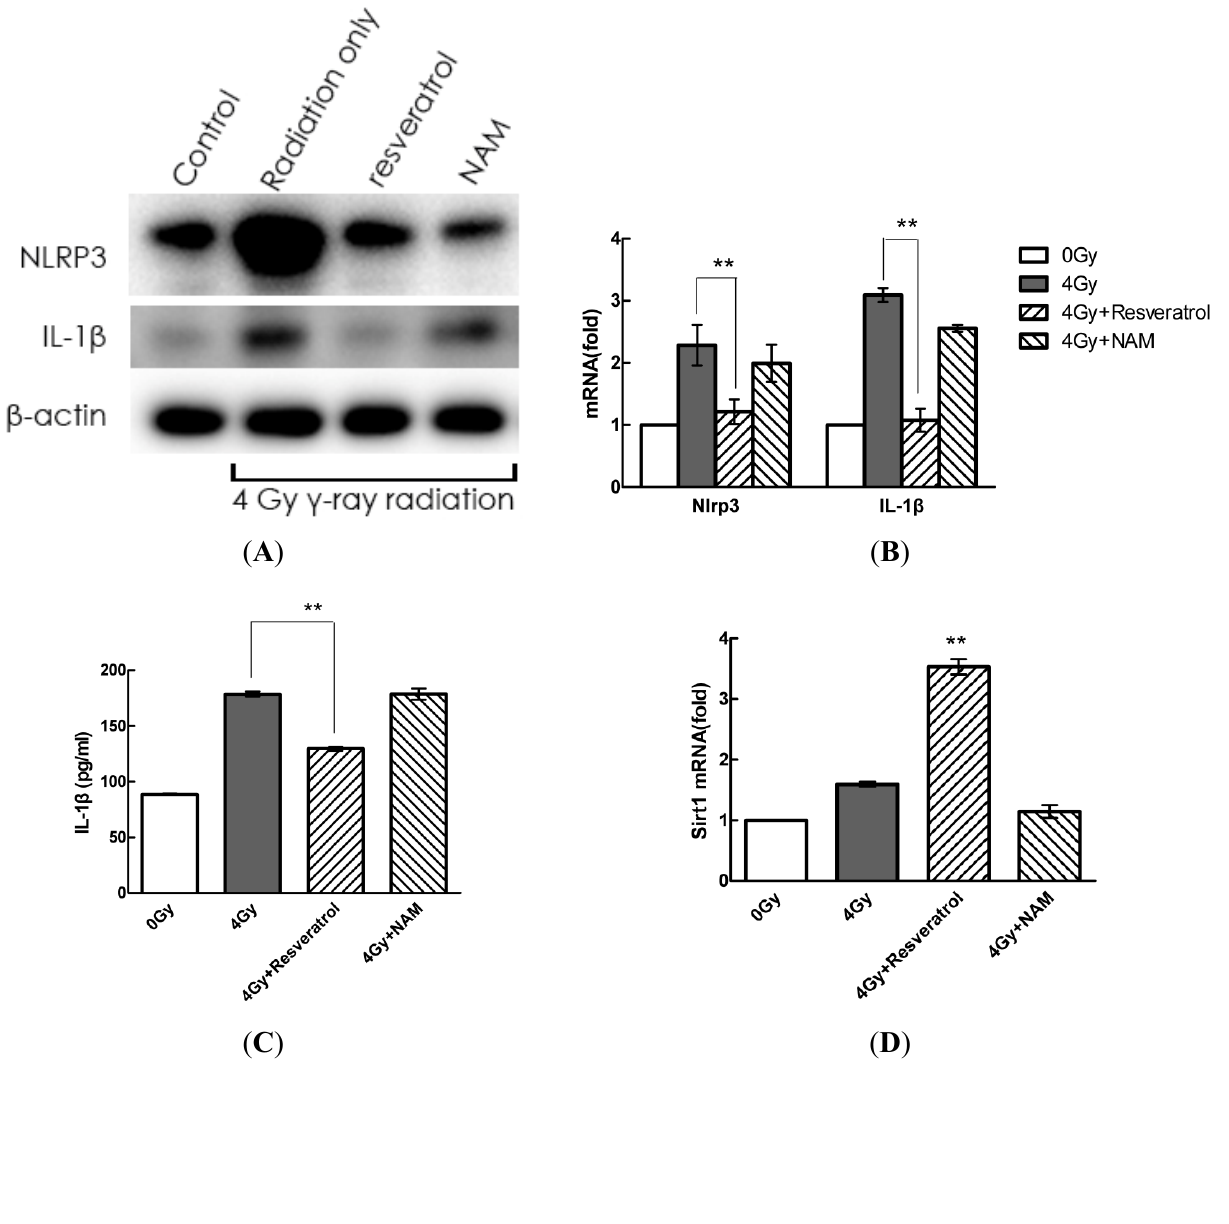
Figure 4. Pharmacological modulation of Sirt1-regulated radiation-induced NLRP3 and IL-1 β expression in MSCs. ( A – D ) Cells were pre-treated with resveratrol (200 μ M) or NAM (20 mM) and subsequently stimulated with radiation for 24 h. Then, extracellular and intracellular protein and mRNA expression of IL-1 β were determined by ELISA, Western blot, and quantitative real-time PCR analyses, respectively. The values are presented as the mean ± SD ( n = 3). * p < 0.05, ** p < 0.01 compared with the radiation